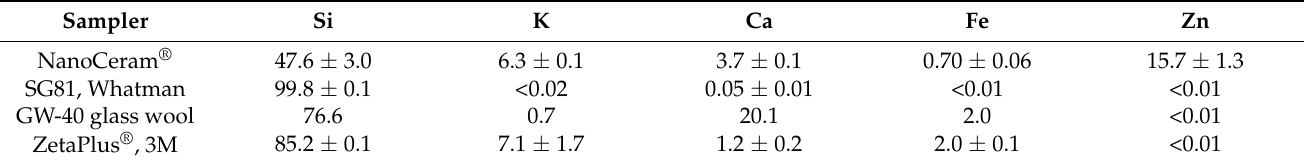
Table 2. Major inorganic constituents of the mineral and organo-mineral based passive sampler materials. Values represent means ± SEM ( n = 3) except for the glass wool which is n = 1.